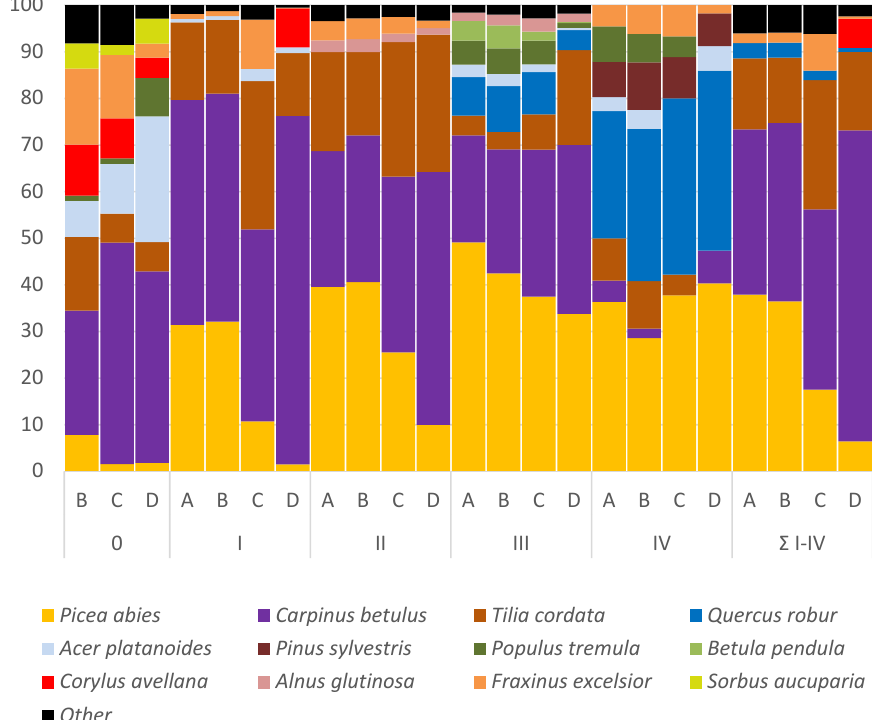
Figure 2. Species structure (frequency % of species in the total number of trees in different classes). A—1982, B—1984, C—1989, D—2014.